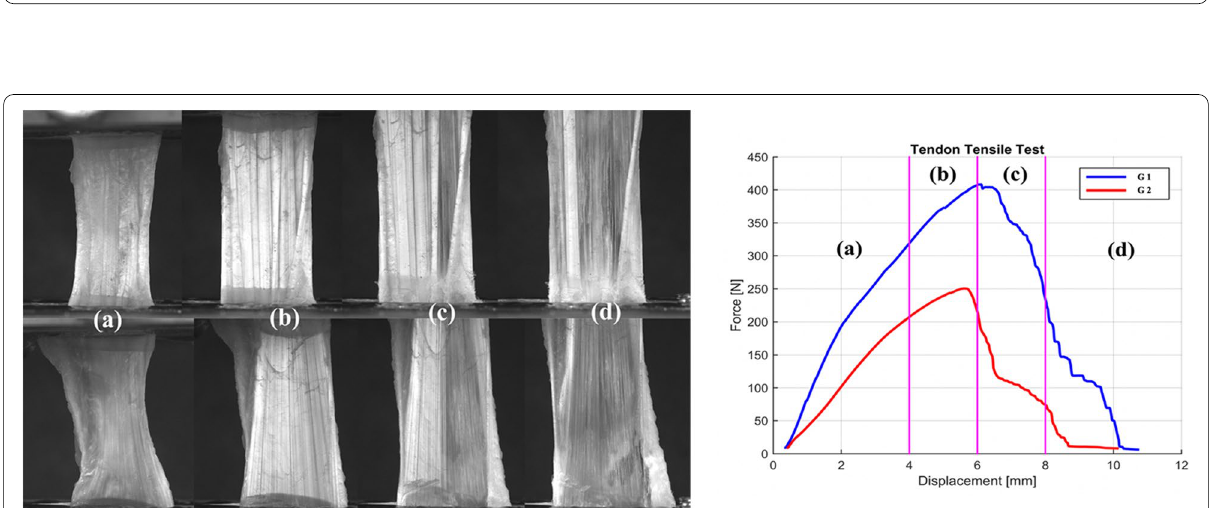
Fig. 5 Comparison between the mean force applied in G1 (muscle tissue preservation) and G2 (removal of muscle tissue) for the variables yield load ( A ), tendon stiffness ( B ), and energy up to maximum load ( C ). For all the comparisons, there was no significant difference between groups ( p 0.11; 0.1; 0.76, =